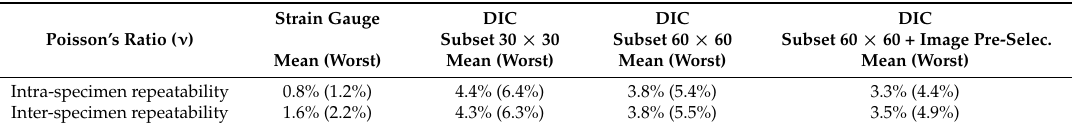
Table 2. Intra- and inter-specimen repeatability for ν values. The mean and the worst (maximum) CV values are reported.